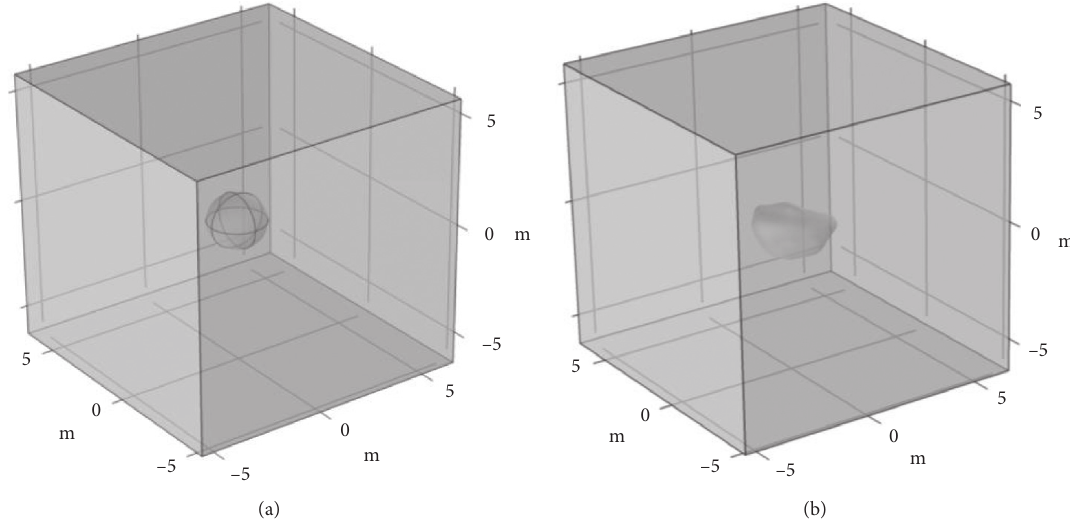
Figure 11: Geometric model. (a) Sphere. (b) Sphere-like.